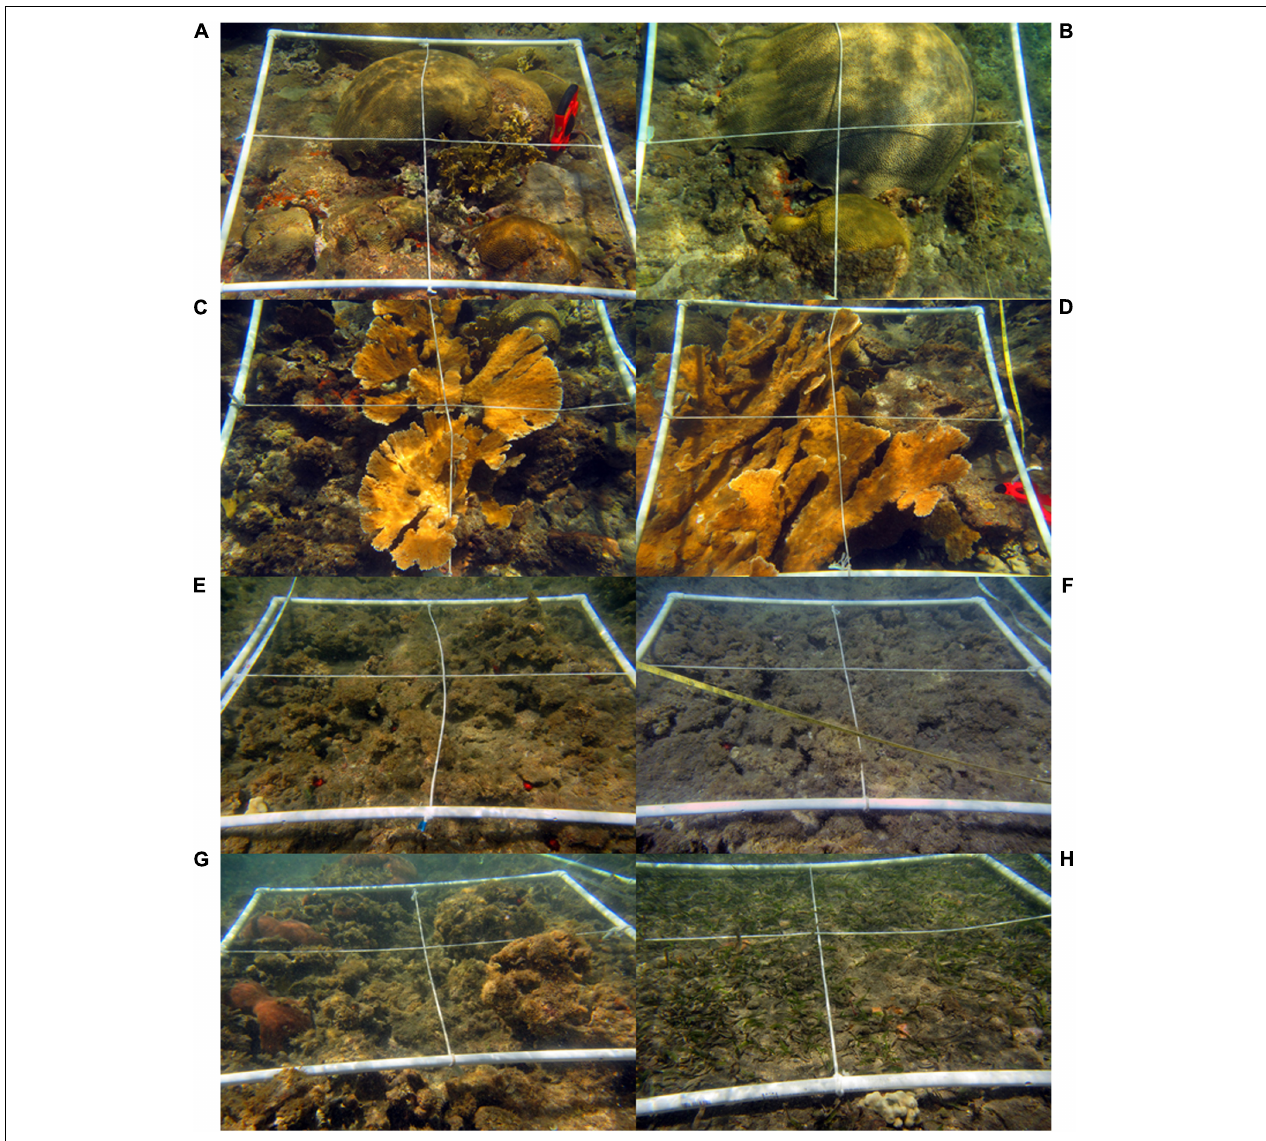
FIGURE 5 | Representative quadrats of the Tómbolo Reef (A–D) and Machuca Reef (E–H) benthos. Note the presence and dominance of reef-building Caribbean Scleractinian coral species at Tómbolo vs. the dominance of dead coral colonies covered by diverse macroalgal species and some seagrasses beds at Machuca. Some of the few live hard coral colonies ( S. siderea ) found at Machuca Reef can be seen on the lower left photo (G)